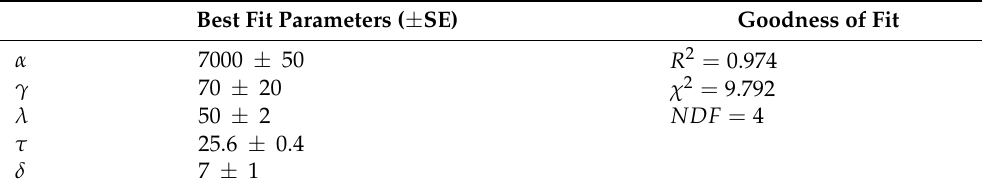
Table 3. Fertility rate function (9) best-fit parameters and their associated standard errors. The good- ness of fit was based on the χ 2 -test, the coefficient of determination R 2 , and the number of degrees of freedom (NDF). The best fitting function is plotted in Figure 3 and in the supplementary